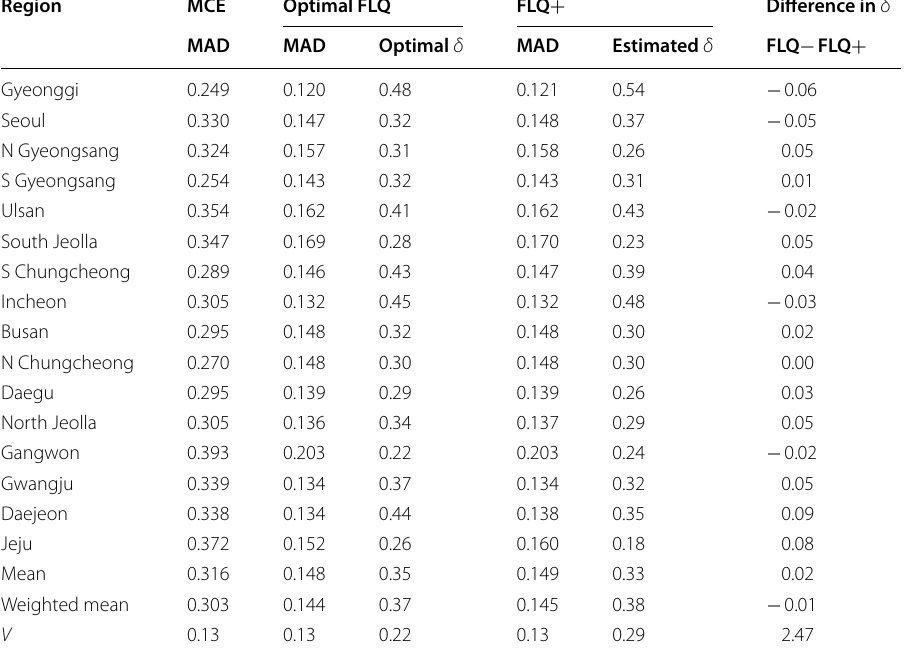
methods. Source: + Difference in δ +